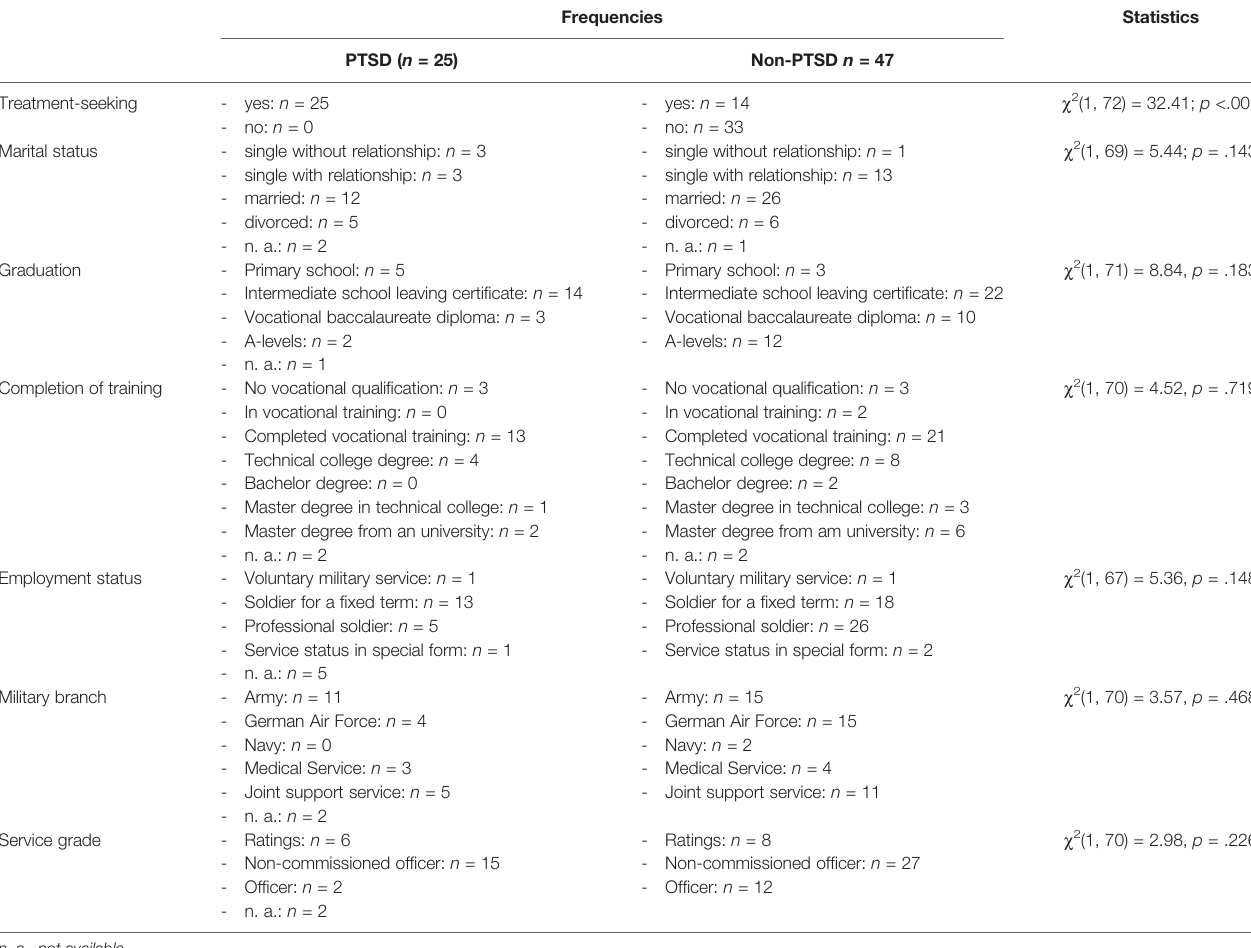
TABLE 1 | Demographic characteristics of participants.